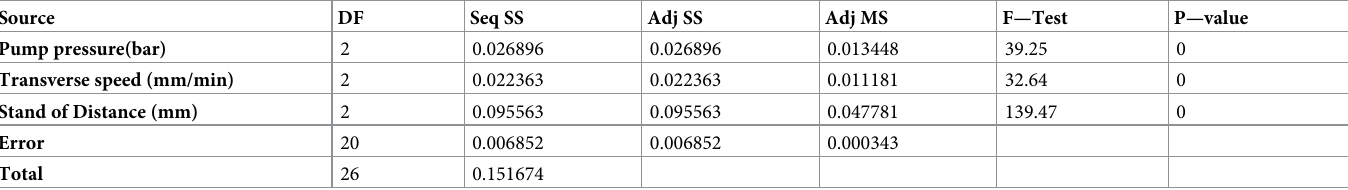
Table 6. ANOVA of 0.1 wt. % filler loaded composite.